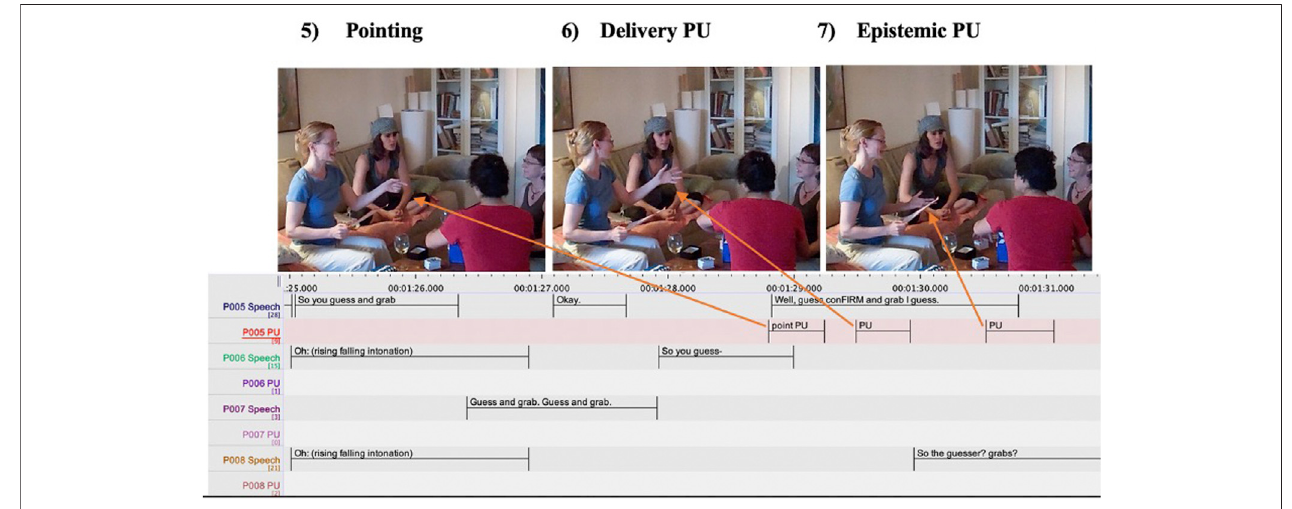
FIGURE 12 | Pointing, delivery PU, and epistemic PU in American